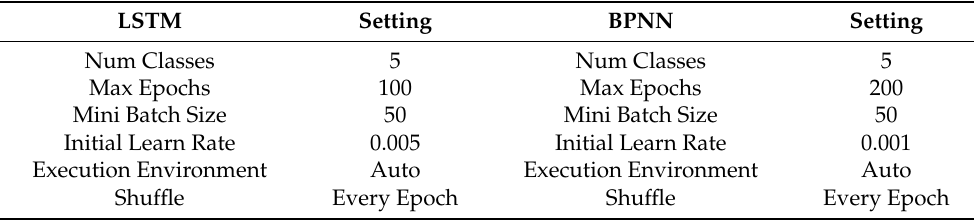
Table 2. Specific neural network parameters.